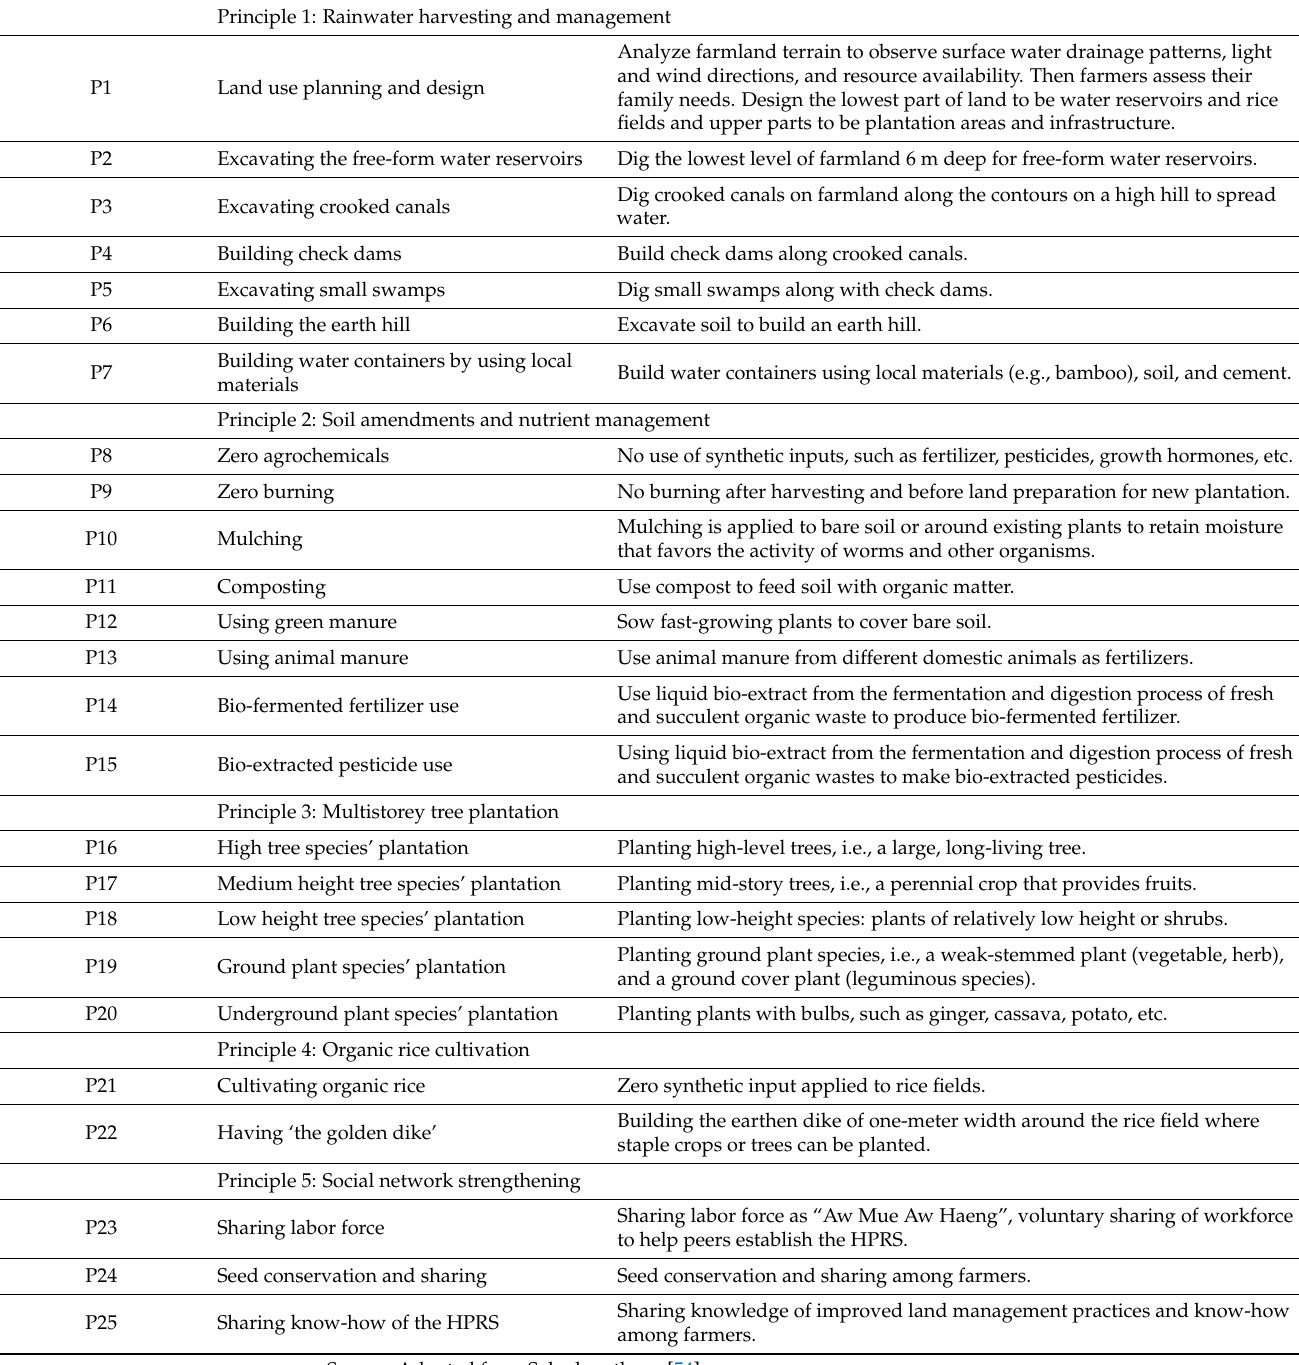
Table 1. Principles and practices of the Hill Pond Rice System in northern